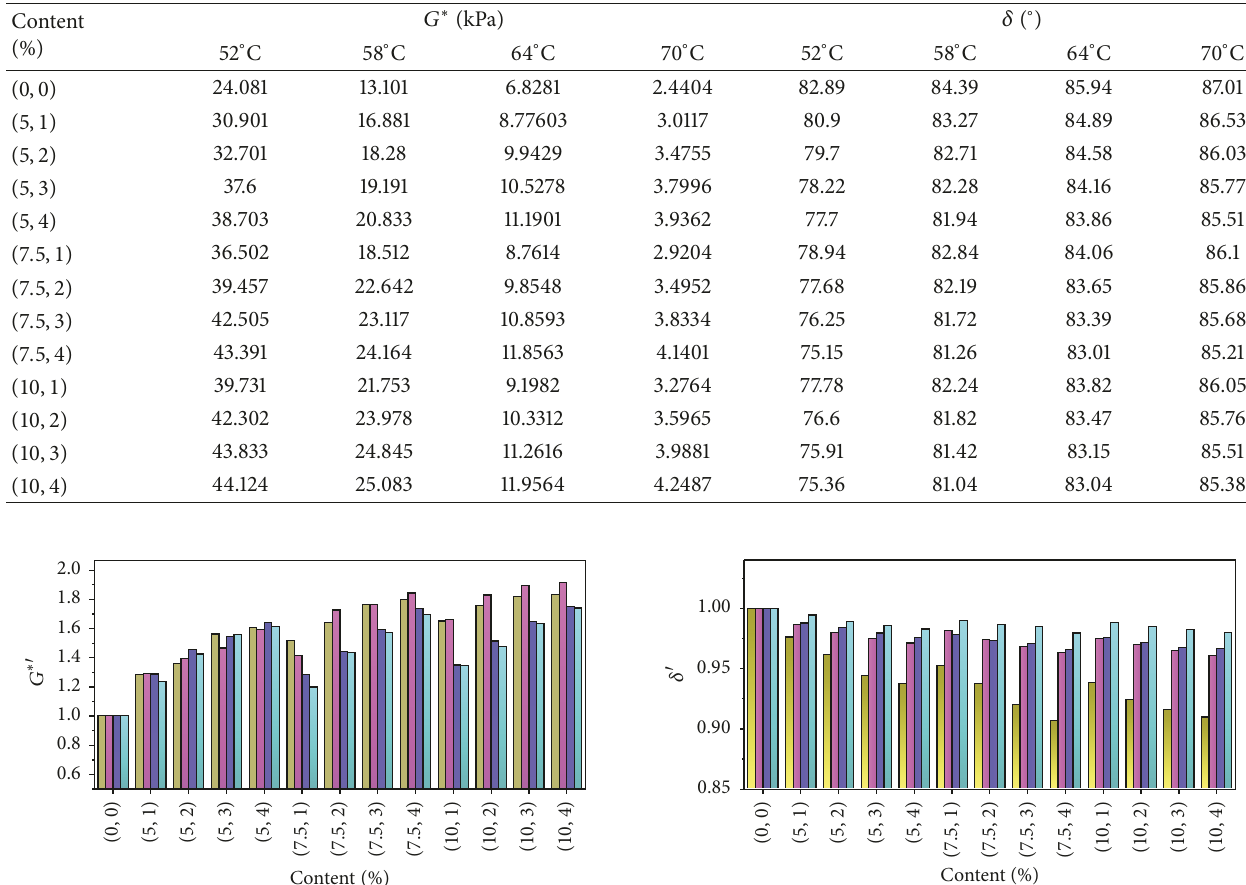
Table 7: Result of DSR test.